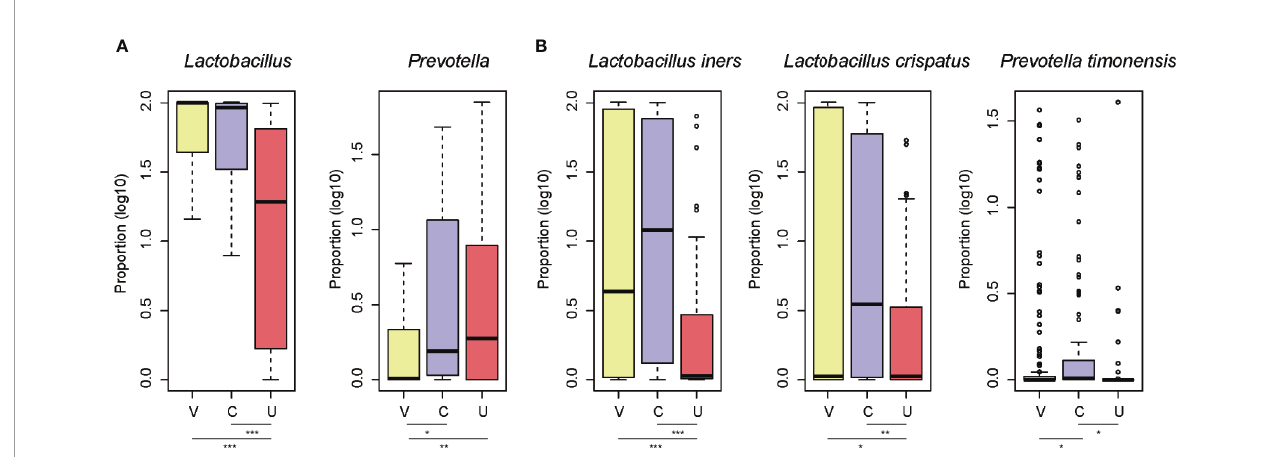
FIGURE 3 | The site-speci fi c genus and species in the three sites of female genital tract. The signature genus for the vagina/cervix (A) and uterine cavity (B) . The three sites are abbreviated as V, C, and U. The points on the top of the boxes represent the outliers. *P-value < 0.05, **P-value < 0.01, ***P-value <